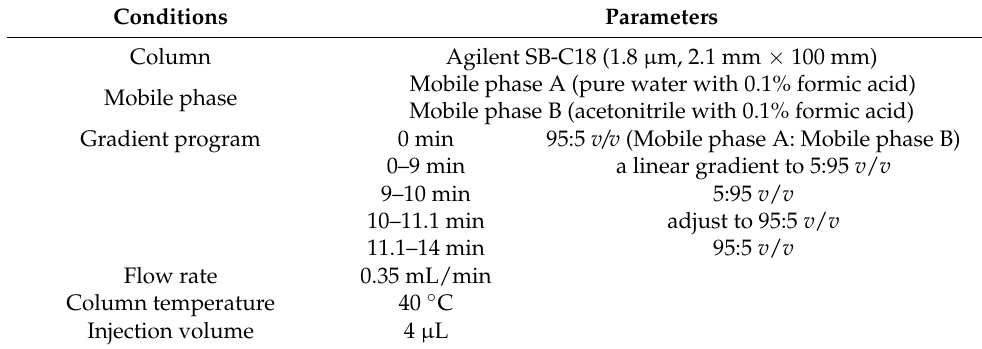
Table 3. Analytical conditions of the Ultra Performance Liquid Chromatography